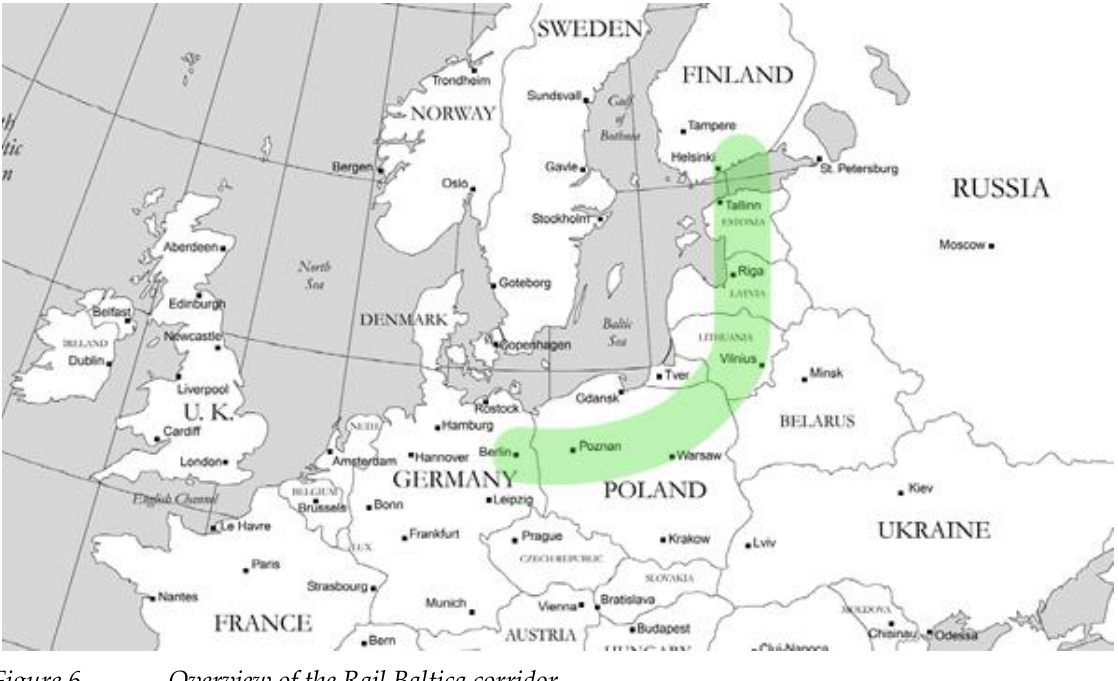
Figure 6. Overview of the Rail Baltica corridor